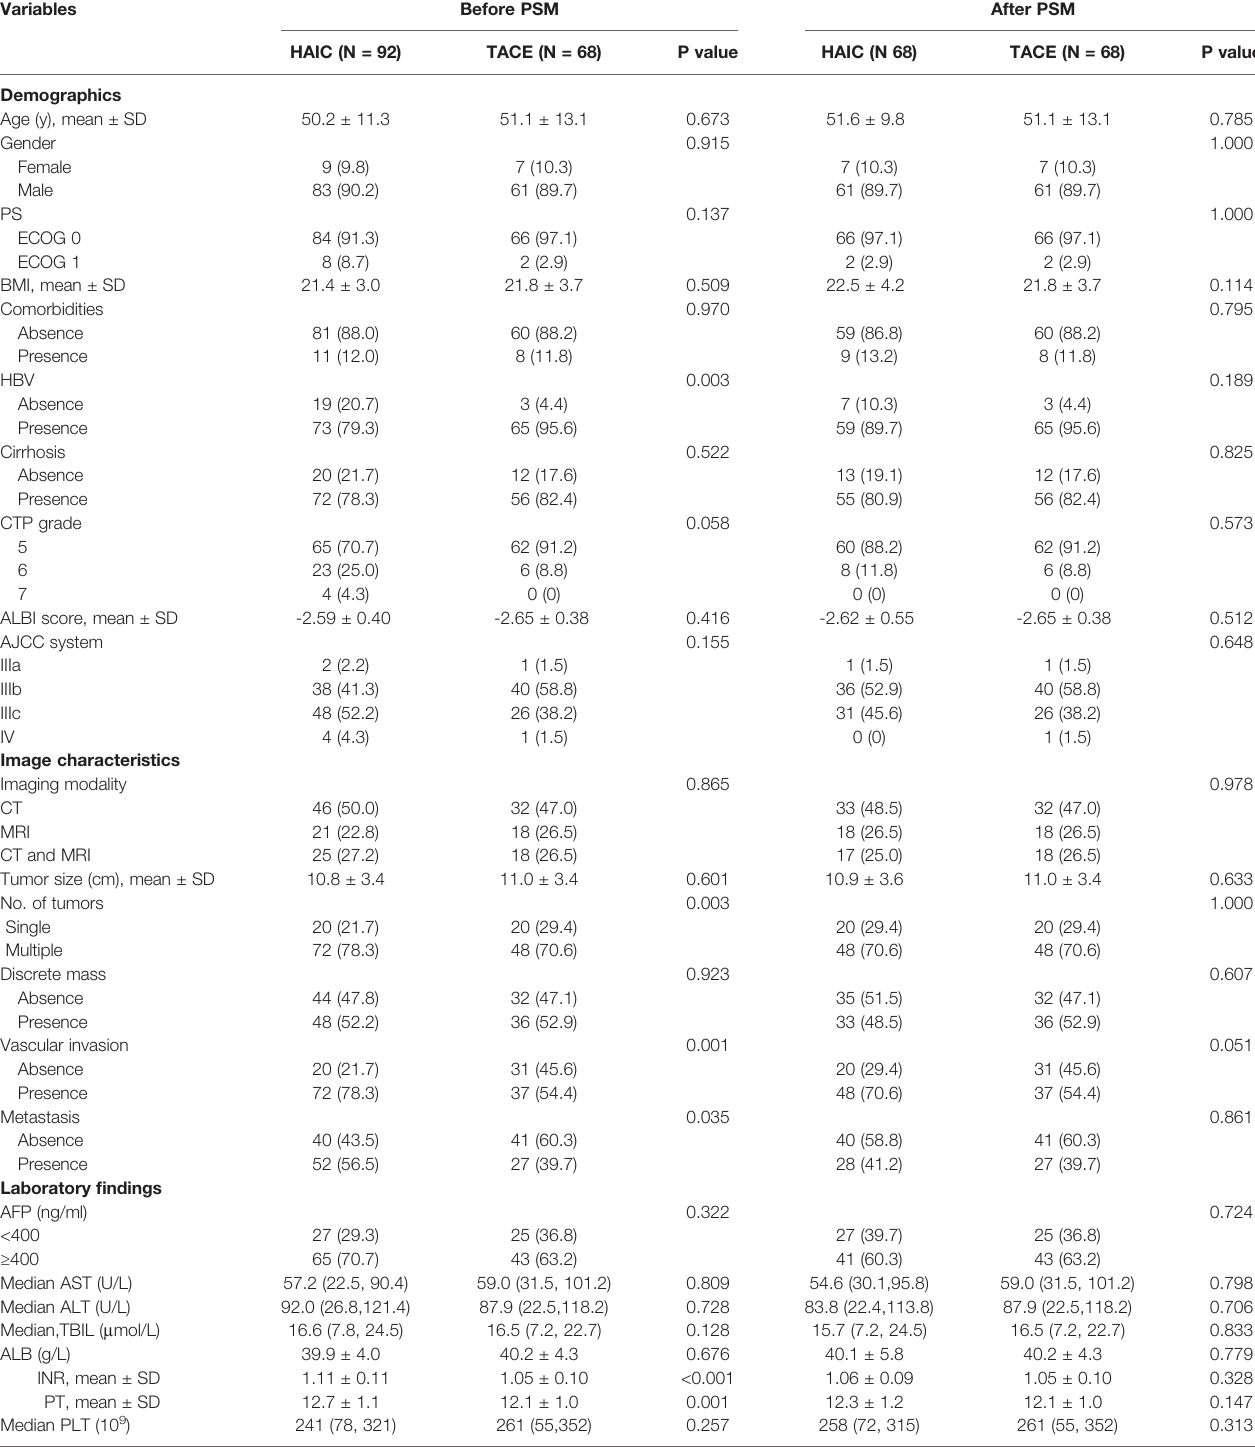
TABLE 1 | Baseline characteristics between TACE group and HAIC group.